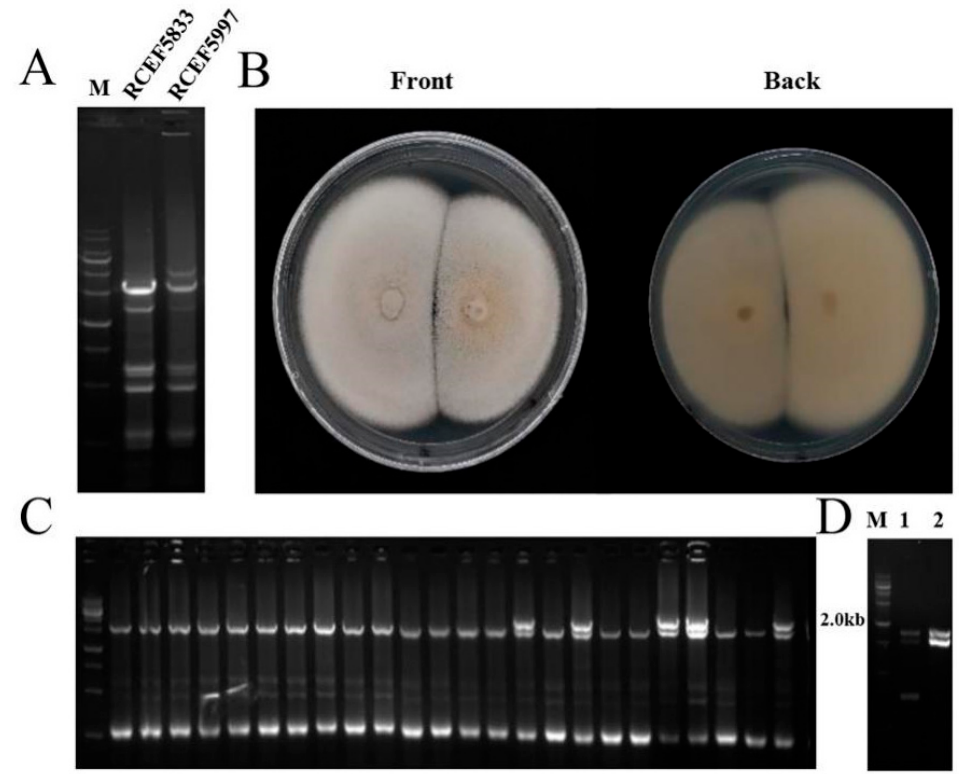
Figure 4. Transmission of CchPV1 virus. ( A ) Strains RCEF5833 and RCEF5997 were genetically distinguished by ISSR markers. ( B ) Confrontation culture of RCEF5997 and RCEF5833, in which the large colony was RCEF5833 and the small colony was RCEF5997. ( C ) ISSR analysis of single-spore isolates. ( D ) dsRNA verification of single-spore isolates, M, DNA marker; lane 1, dsRNA segments of RCEF5997; lane 2, dsRNA segments of RCEF5833 (Vi).